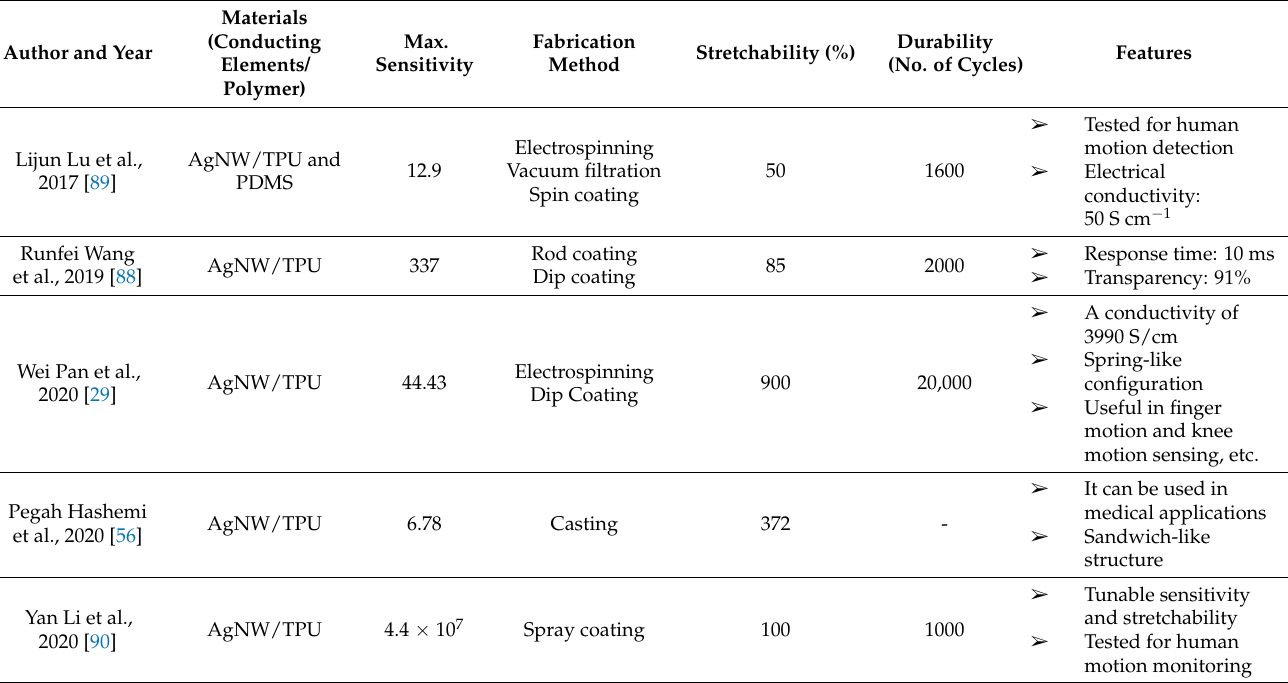
Table 3. An overview of recent stretchable strain sensors made of AgNW/TPU